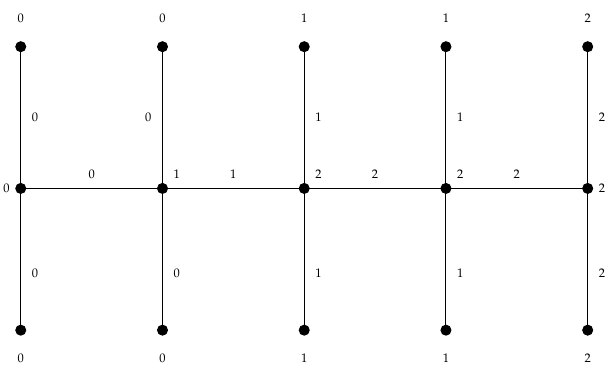
Figure 12. 3-TEMC labeling of DCO